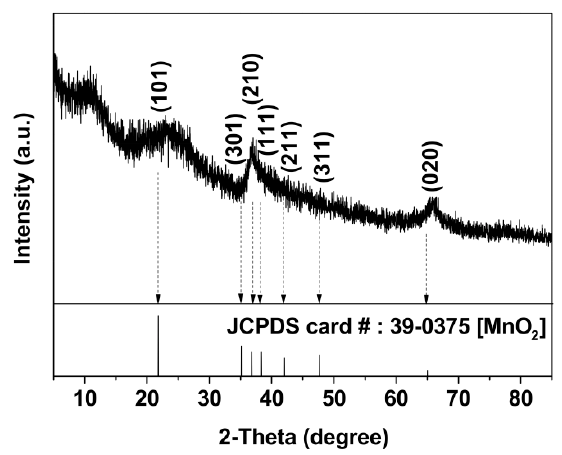
Figure 2. XRD pattern of Mn oxides of the BMO aggregates.